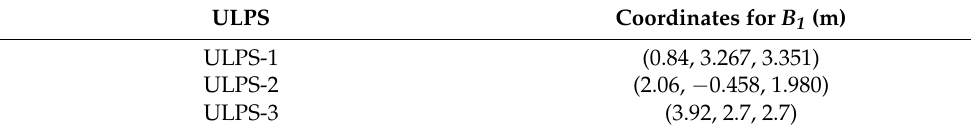
Table 1. Coordinates of the central beacon B 1 for every ULPS in the considered